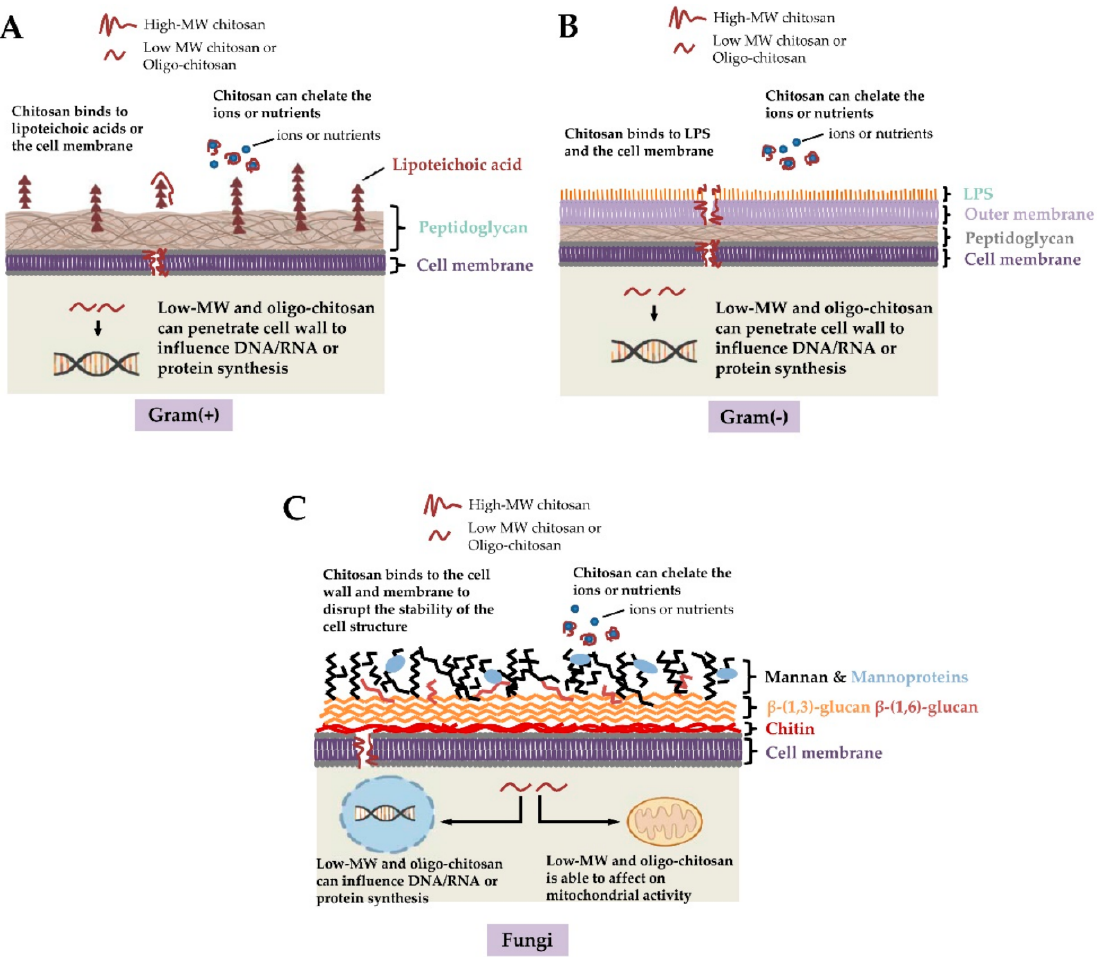
Figure 7. Mechanism of antimicrobial property exhibited by chitosan (taken [16] under Creative Commons License).